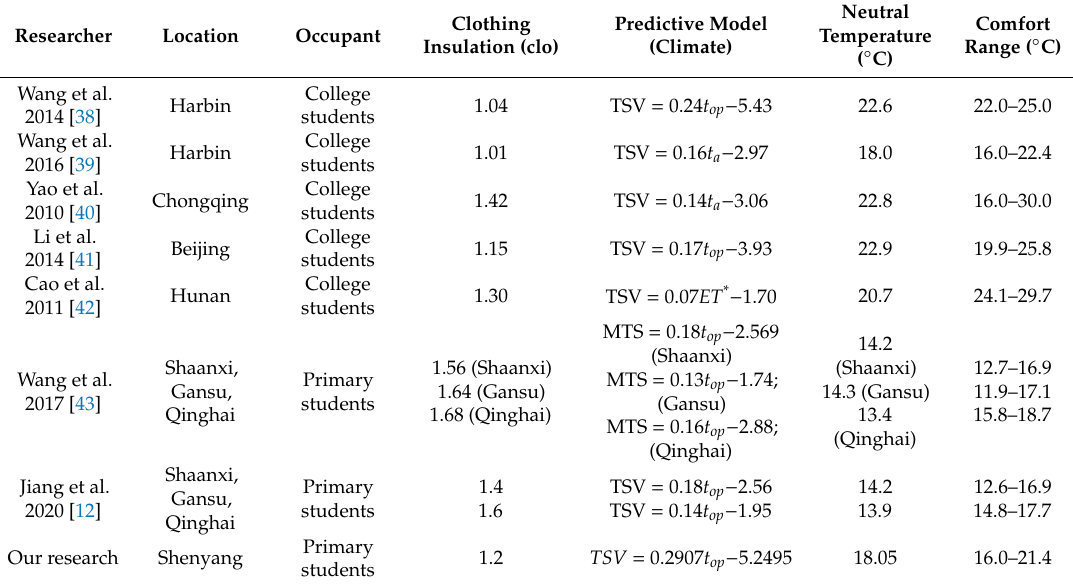
Table 5. Comparison of our results with other field study